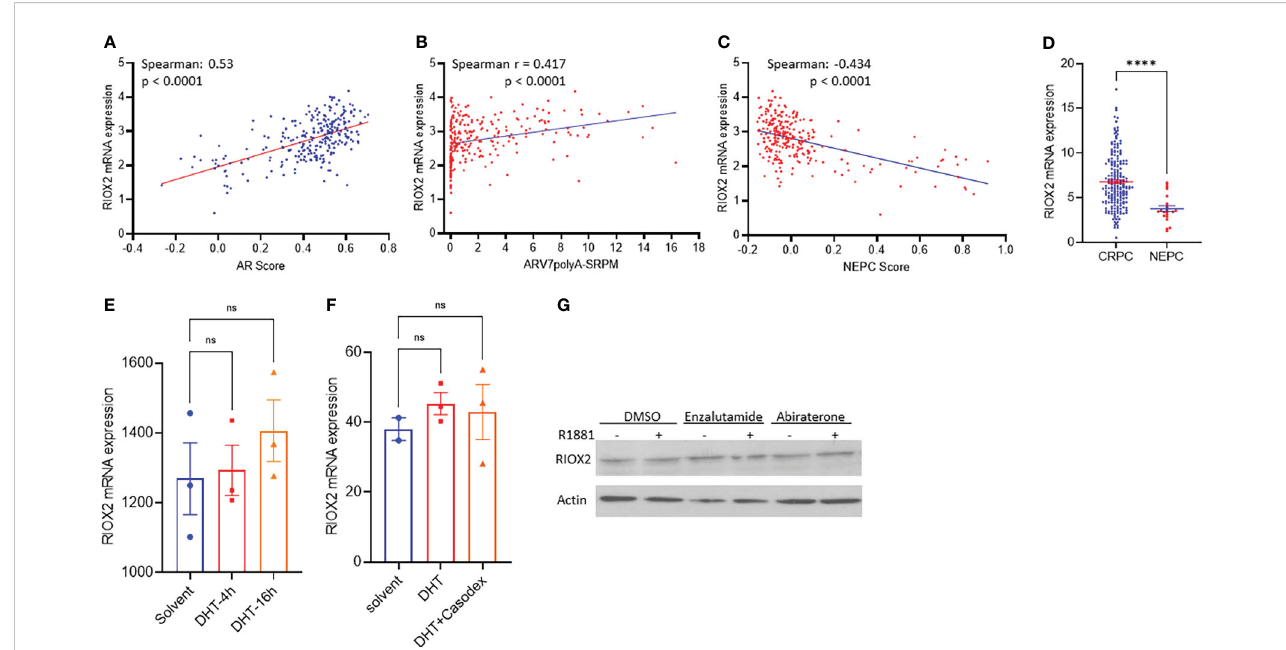
FIGURE 5 RIOX2 upregulation is associated with AR signaling activity in CRPC cancers. (A – C) Spearman correlation analysis was conducted between RIOX2 expression levels and AR signaling activity index, AR-V7 splicing, and NEPC index using the SU2C/PCF Dream Team RNA-seq dataset (17). (D) RIOX2 mRNA expression levels were compared between CRPC and NEPC tissues using the SU2C/PCF dataset. The asterisks indicate a signi fi cant difference (Student t -test, ****p < 0.0001). Case numbers: CRPC, 210; NEPC, 22. (E, F) RIOX2 mRNA expression data were extracted from NCBI GDS2782 (22) and GDS3111 (21). LNCaP cells were stimulated with dihydrotestosterone (DHT, 10 nM) with or without the AR antagonist Casodex (10 m M) in 8% cFBS- containing culture media. RIOX2 gene expression was examined using the Affymetrix Human Genome U133AB platform (21, 22). (G) LNCaP cells were treated with R1881 (1.0 nM) in 2% cFBS with or without Enzalutamide or Abiraterone (10 m M) overnight. RIOX2 protein expression was assessed in western blot assay (14). Actin blot served as a protein loading control. ns, none signi fi